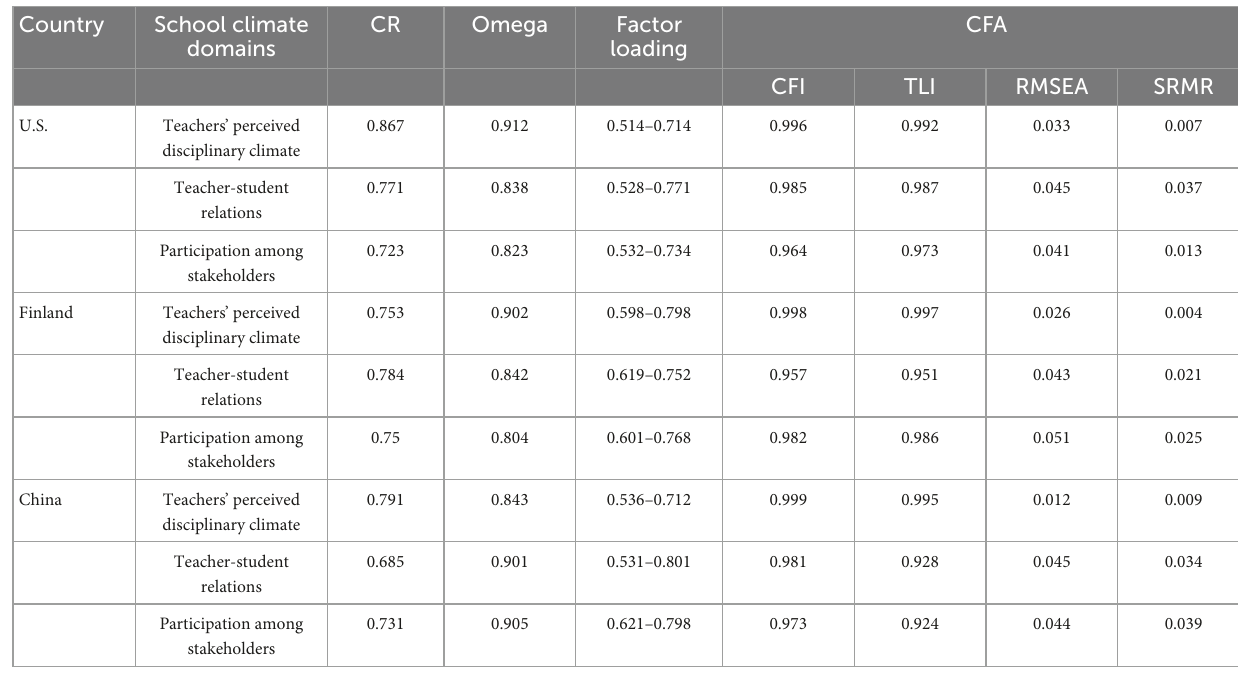
TABLE 3 Reliability and convergent